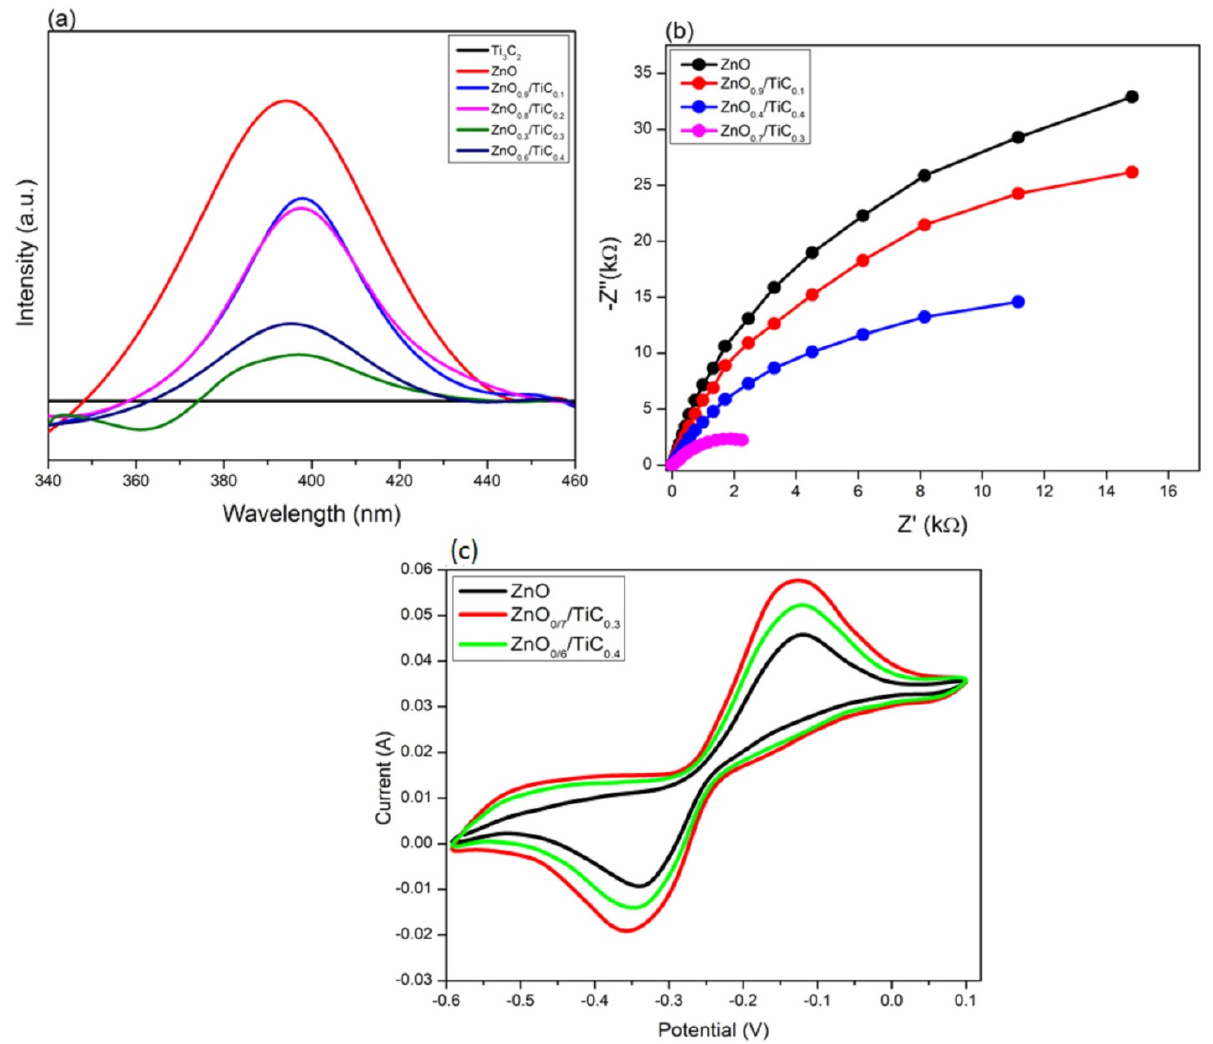
Figure 4. ( a ) PL spectra of ZnO, Ti 3 C 2 and ZnO/Ti 3 C 2 composites; ( b ) EIS Nyquist plots of ZnO, ZnO 0.9 /TiC 0.1 , ZnO 0.7 /TiC 0.3 and ZnO 0.6 /TiC 0.4 ; ( c ) CV curves of ZnO, ZnO 0.7 /TiC 0.3 and ZnO 0.6 /TiC 0.4 .